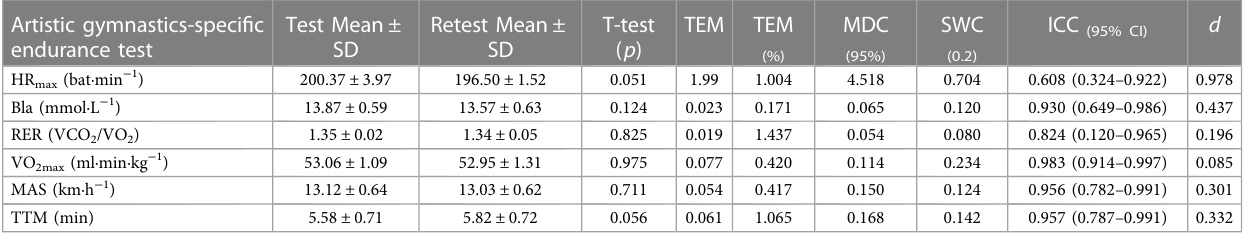
TABLE 3 Reliability outcomes of the artistic gymnastics-speci fi c endurance test. Artistic gymnastics-speci fi c